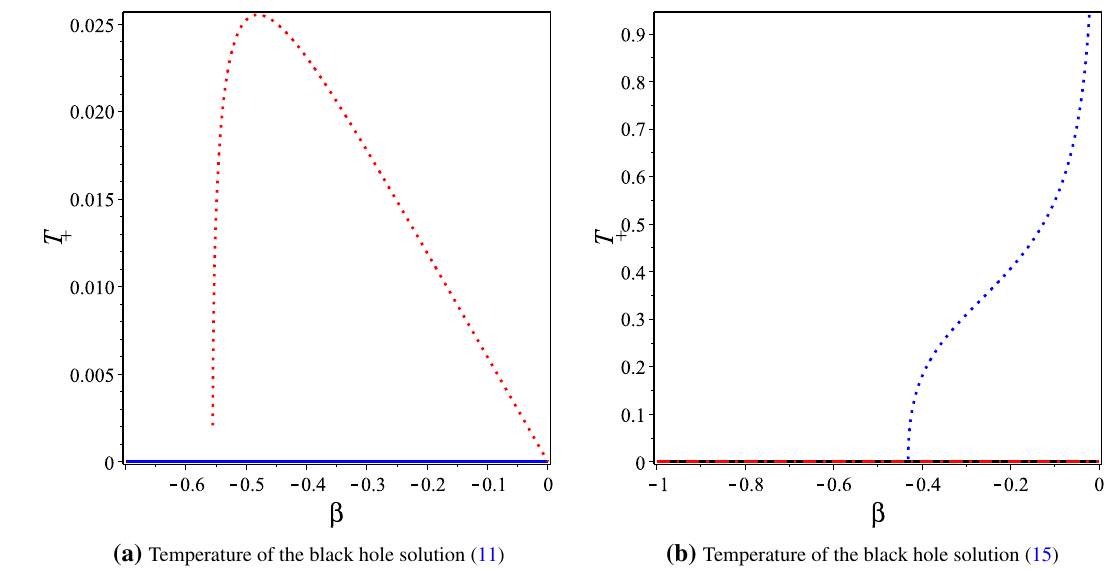
( a ) Temperature of the black hole solution (11) (b) Temperature of the black hole solution (15) Fig. 5 Schematic plot of the temperature of the black holes (11) and (15) versus the dimensional parameter β